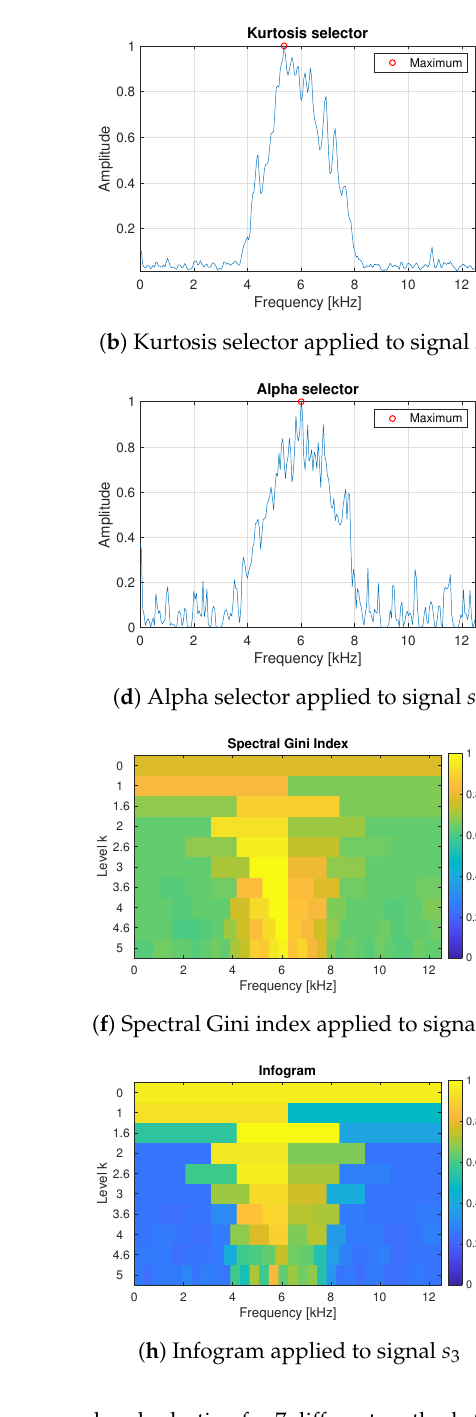
Figure A3. Normalized results of the informative frequency band selection for 7 different methods for the signal s 3